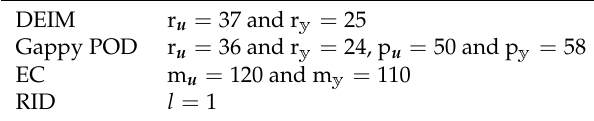
Table 5. Parameters of the hyper-reduced models used in Table